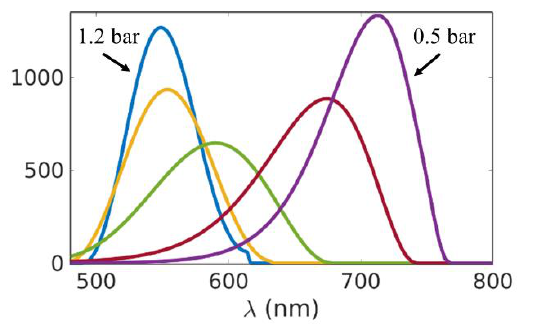
Fig. 3. Filtered visible band of the spectrum at different pressures (1.2, 1, 0.8, 0.6 and 0.5 bar from left to right) at 66 cm inside the capillary.